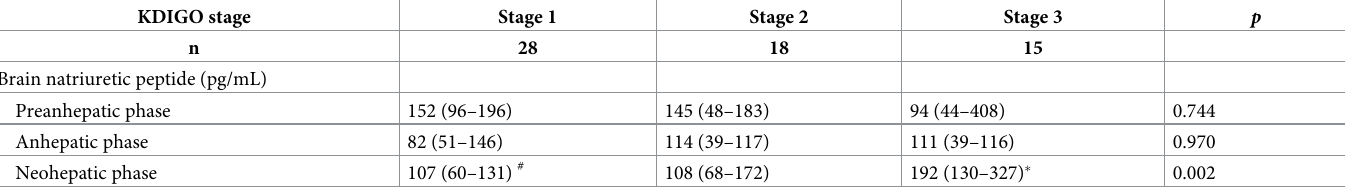
Table 4. Comparisons of serum brain natriuretic peptide levels according to KDIGO stage during living donor liver transplantation. KDIGO stage